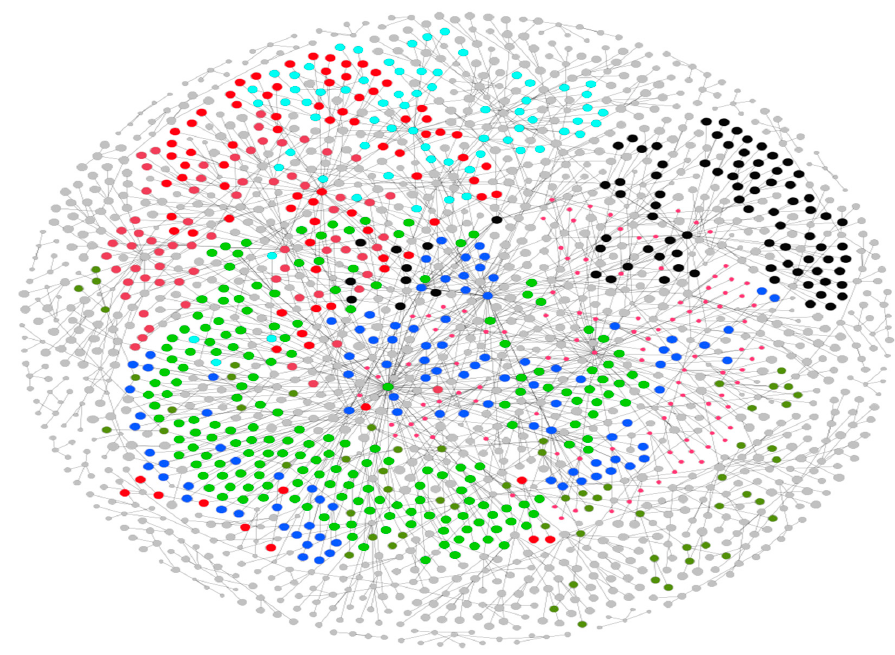
Figure 14. Clustered network of authors with co-authors, source title, and publication title.